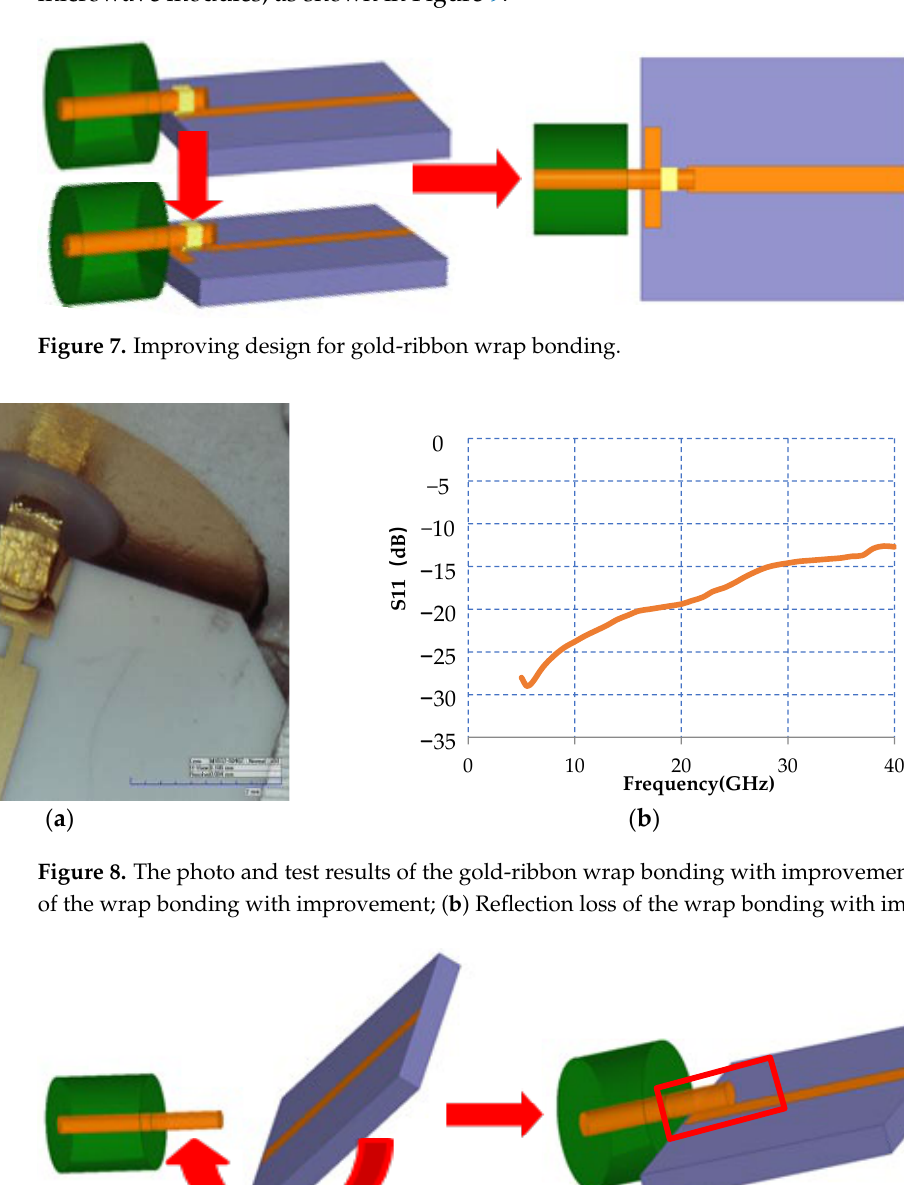
Table 3. Stress simulation results of the above structures.